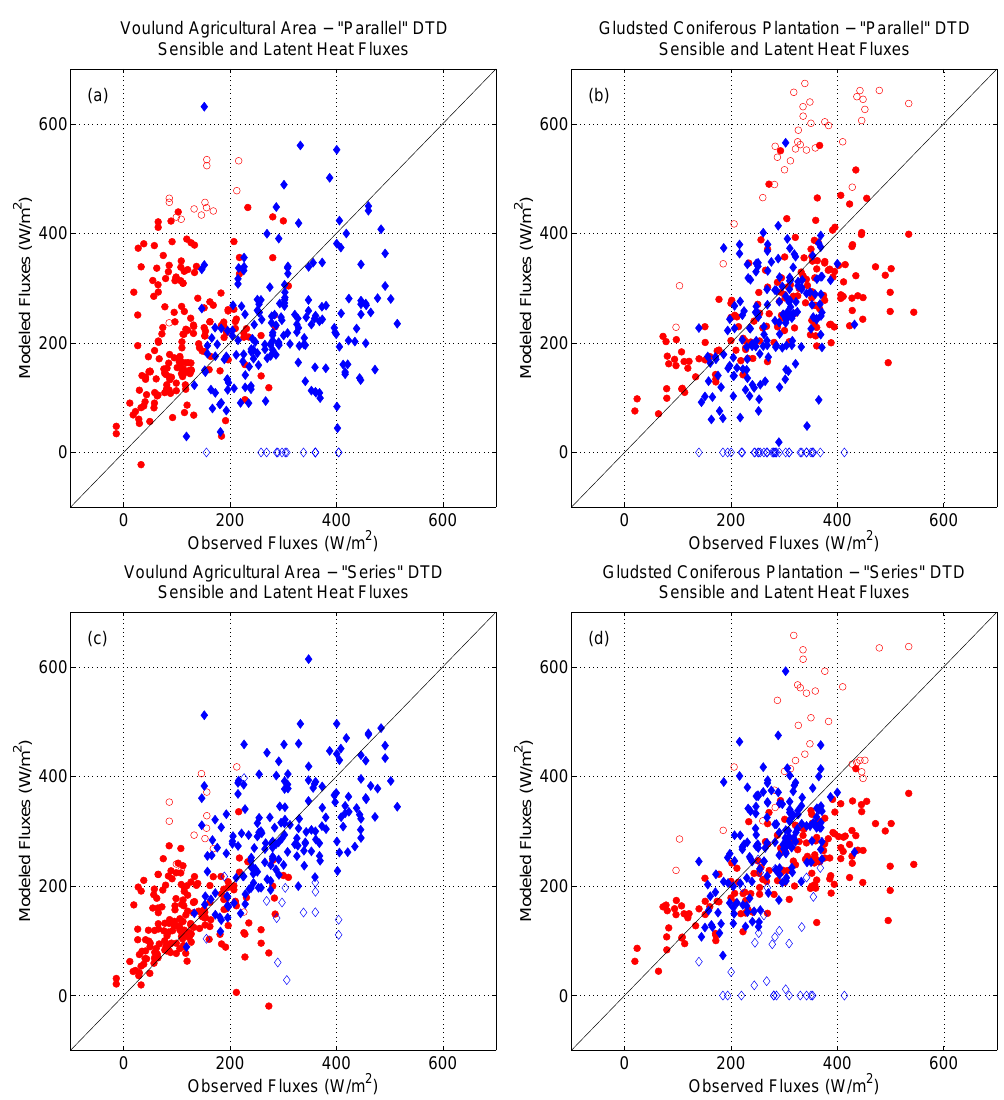
Figure 4. Comparison of DTD modelled vs. observed sensible heat (red dots) and latent heat (blue diamonds) fluxes for the period 2009– 53 2013 over the Voulund agricultural area, panels (a) and (c) , and Gludsted coniferous plantation, panels (b) and (d) . The satellite input was taken from 930m resolution MODIS instrument on board Terra and Aqua satellites. Modelled fluxes are instantaneous at the time of daytime Terra/Aqua overpass and observed fluxes are 30min averaged EC measurements. Empty symbols indicate model runs when “parallel” DTD could not converge to a plausible solution (LE < 0Wm − 2 ) and instead a backup formulation was used. In the top panels the “parallel” implementation of DTD was used, in the lower panels the “series”